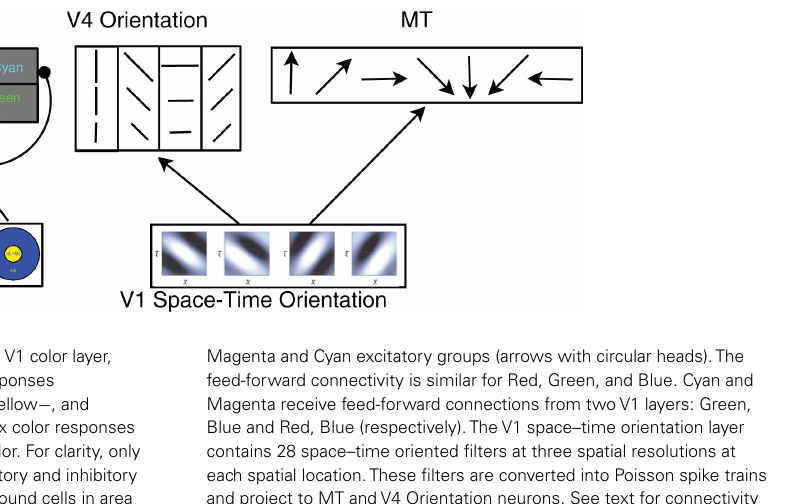
FIGURE 1 |Architecture of the cortical model. In theV1 color layer, there are four color opponent (center + /surround − ) responses corresponding to green + /red − , red + /green − , blue + /yellow − , and yellow + /blue − .TheV4 color layers are composed of six color responses with both excitatory and inhibitory neurons for each color. For clarity, only the connections forYellow are shown.V4Yellow excitatory and inhibitory populations receive input from yellow center, blue surround cells in area V1 (normal arrow), and theV4 yellow inhibitory population inhibits the